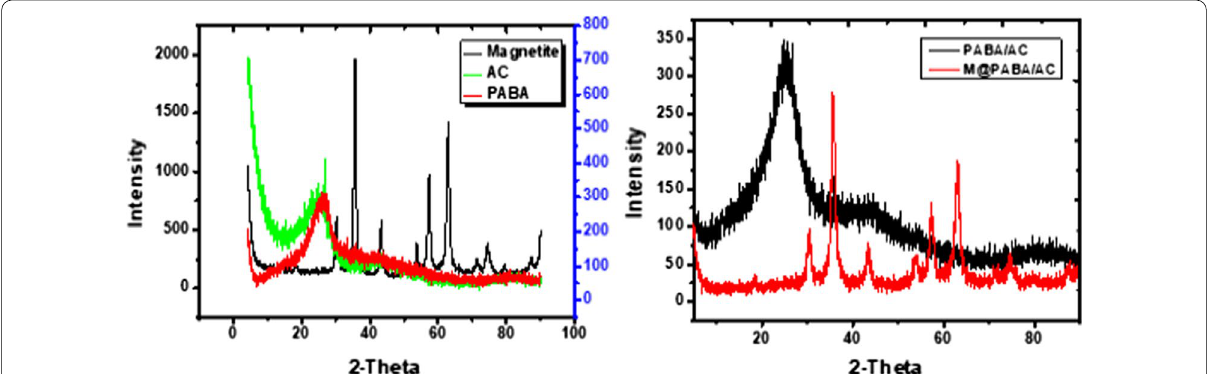
Fig. 3 XRD patterns showing the crystallographic structure of the as-synthesized materials. Magnetite refers to Fe 3 O 4